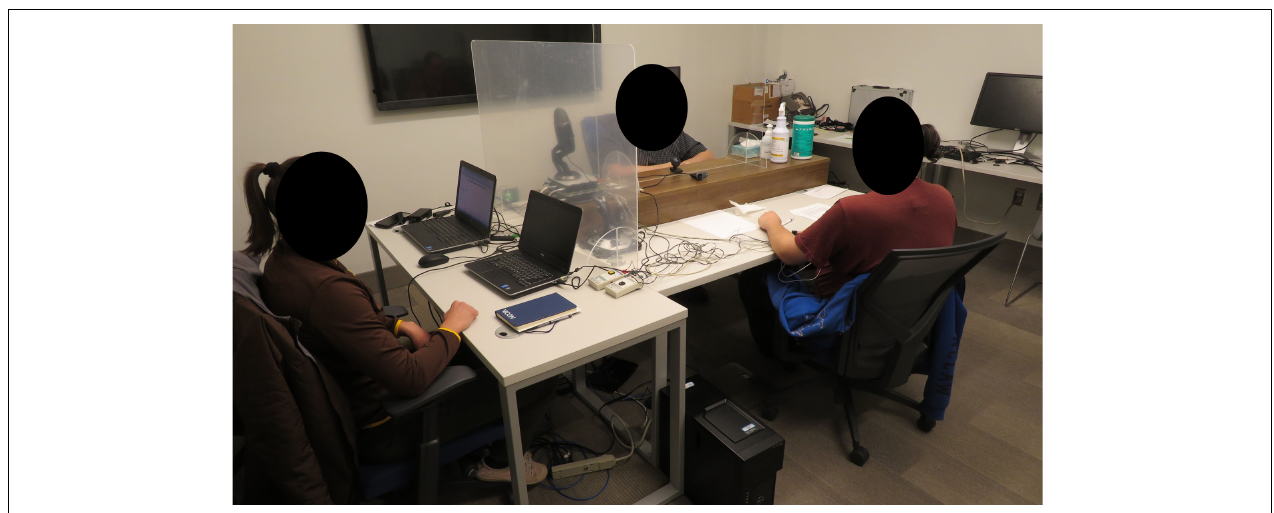
FIGURE 1 | Two participants in the study protocol, sitting facing each other separated by a plexiglass barrier. The experimenter sits to the side with the data collection